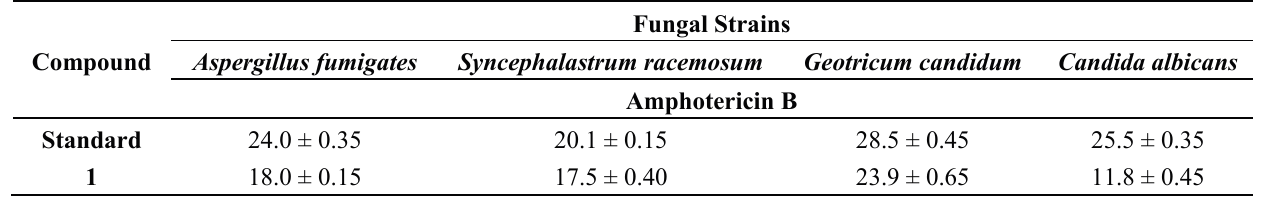
Table 7. Antifungal activity of the synthesized compound 1 (Zone of inhibition; diameter in mm).